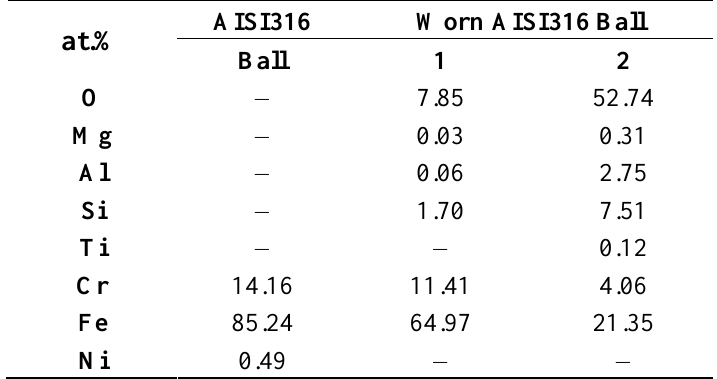
Table 4. Composition of the AISI316 ball flattened surface in contact with the coating after the wearing test. The analyses were performed in the areas pointed out in the inset of Figure